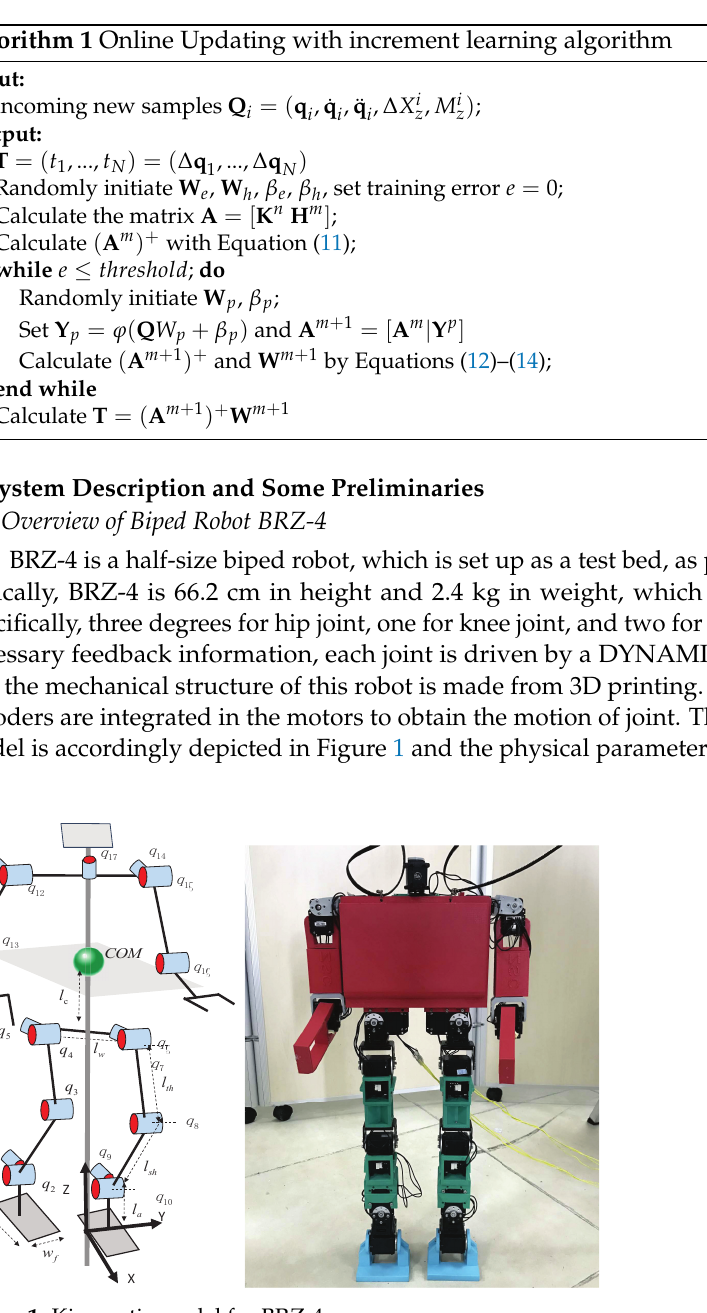
Figure 1. Kinematic model for BRZ-4. Table 1. Basic Physical Parameters of